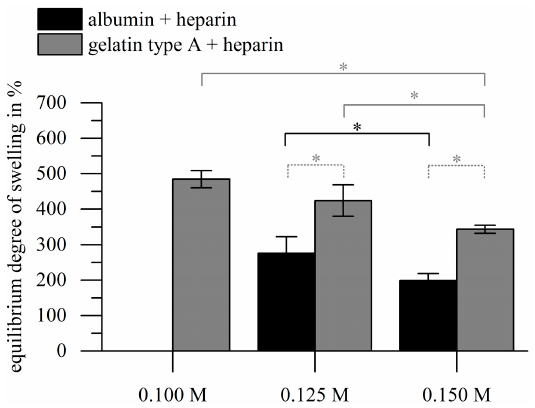
Figure 4. Results of the gravimetric characterization of the hydrogels. Hydrogels were prepared with gelatin type A or albumin (10 wt %), heparin (1 wt %), and different EDC concentrations. At 0.1 M EDC, no crosslinking was achieved for albumin-based gels. The EDS decreased with increasing EDC concentration for both biopolymers (asterisks with solid lines: p < 0.05; grey lines refer to gelatin, black line refers to albumin; n = 3), while the EDS of gelatin gels was significantly higher compared to the albumin gels in all cases (asterisk with dotted lines: p < 0.01; n = 3).